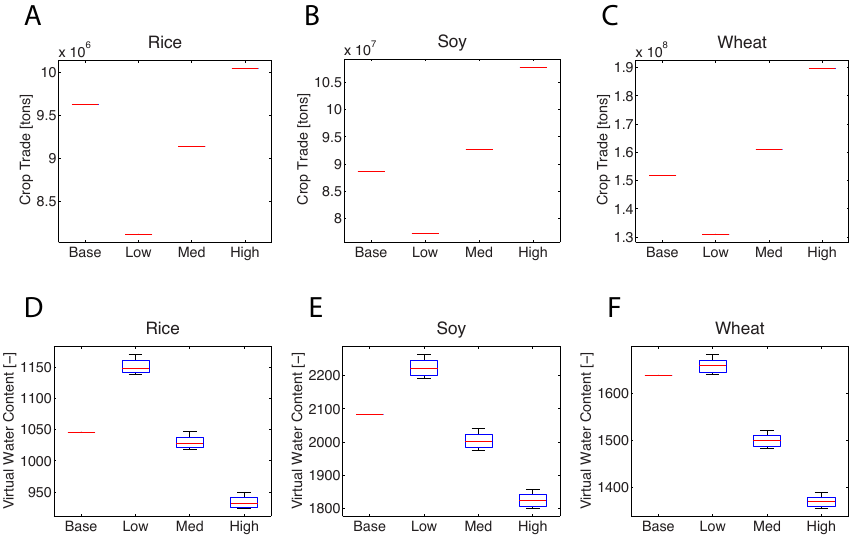
Fig. 3. Total crop trade [metric tons] and mean VWC [dimensionless] by crop and yield scenario. The x axis in each plot indicates the yield scenario: “Base” indicates the baseline scenario, “Low” indicates the low-productivity scenario, “Med” indicates the medium-productivity scenario, and “High” indicates the high-productivity scenario. Box and whisker plots in panels ( d ), ( e ), and ( f ) indicate the median (red line) and the quantiles (blue box) of the VWC values. Note that the volume of the wheat commodity trade is the largest of the commodity trades.